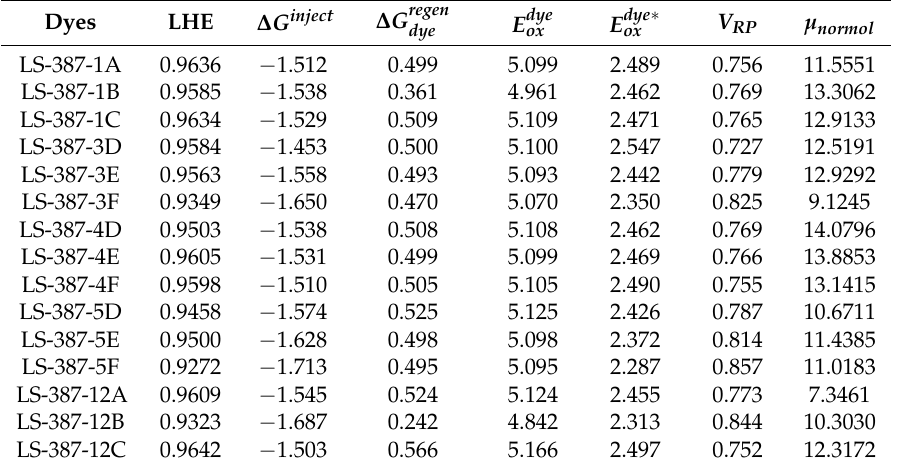
Table 7. Chemical parameters in DMF solvent. ( ∆ G inject , ∆ G regen Dyes LHE ∆ G inject ∆ G